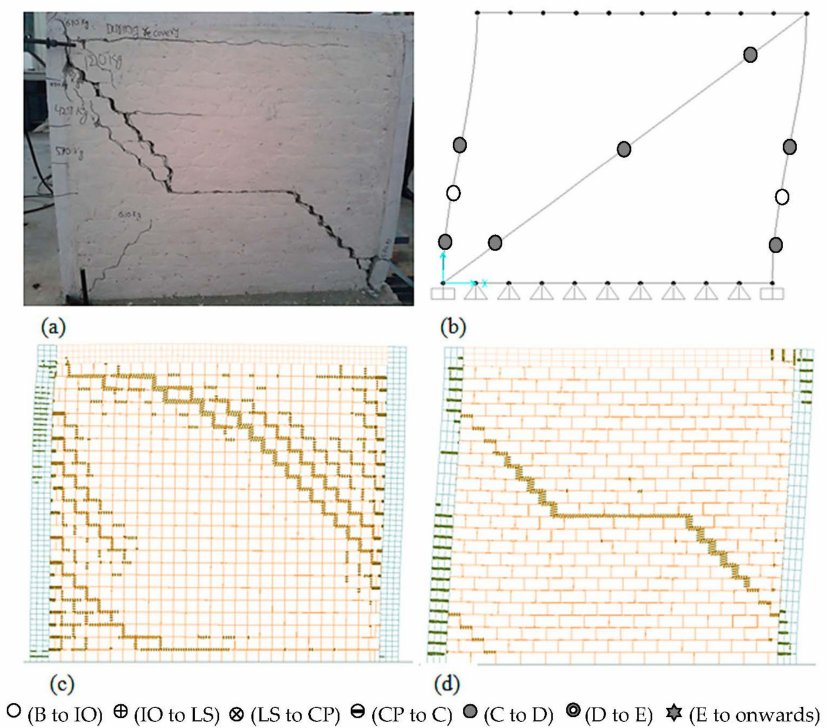
Figure 16. Comparison of IFM damage profiles for ( a ) physical test performed by Waqar Ahmad (2013) [26]; ( b ) FEMA strut model; ( c ) AEM; ( d ) AEM with cold